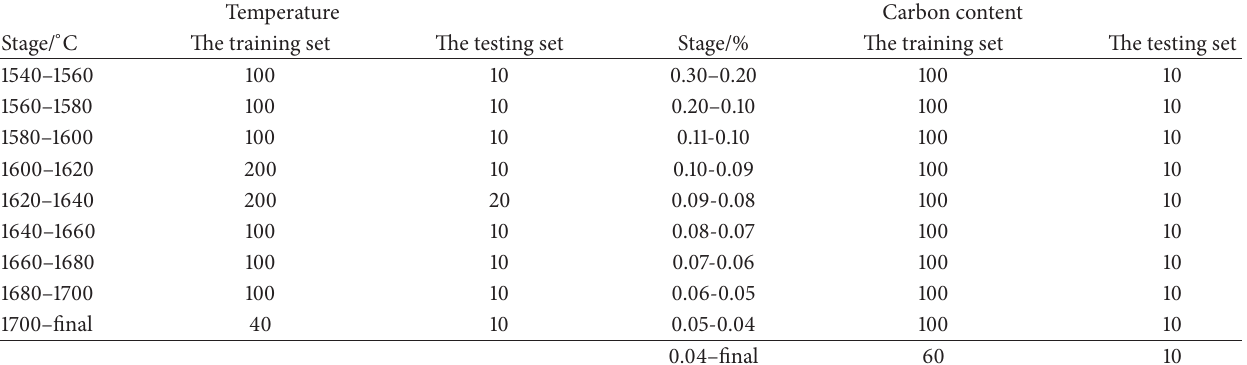
Table 1: The training set and the testing set for multistage temperature models and carbon content